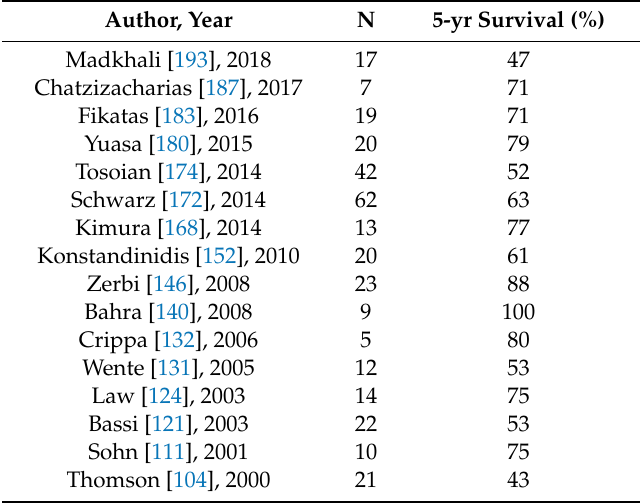
Table 5. Cumulative 5-year survival rates following surgical treatment of